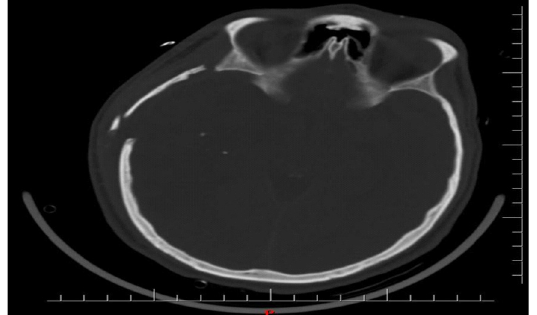
Figure 1. Displaced skull fracture. Figure 2. Epidural hematoma and cerebral